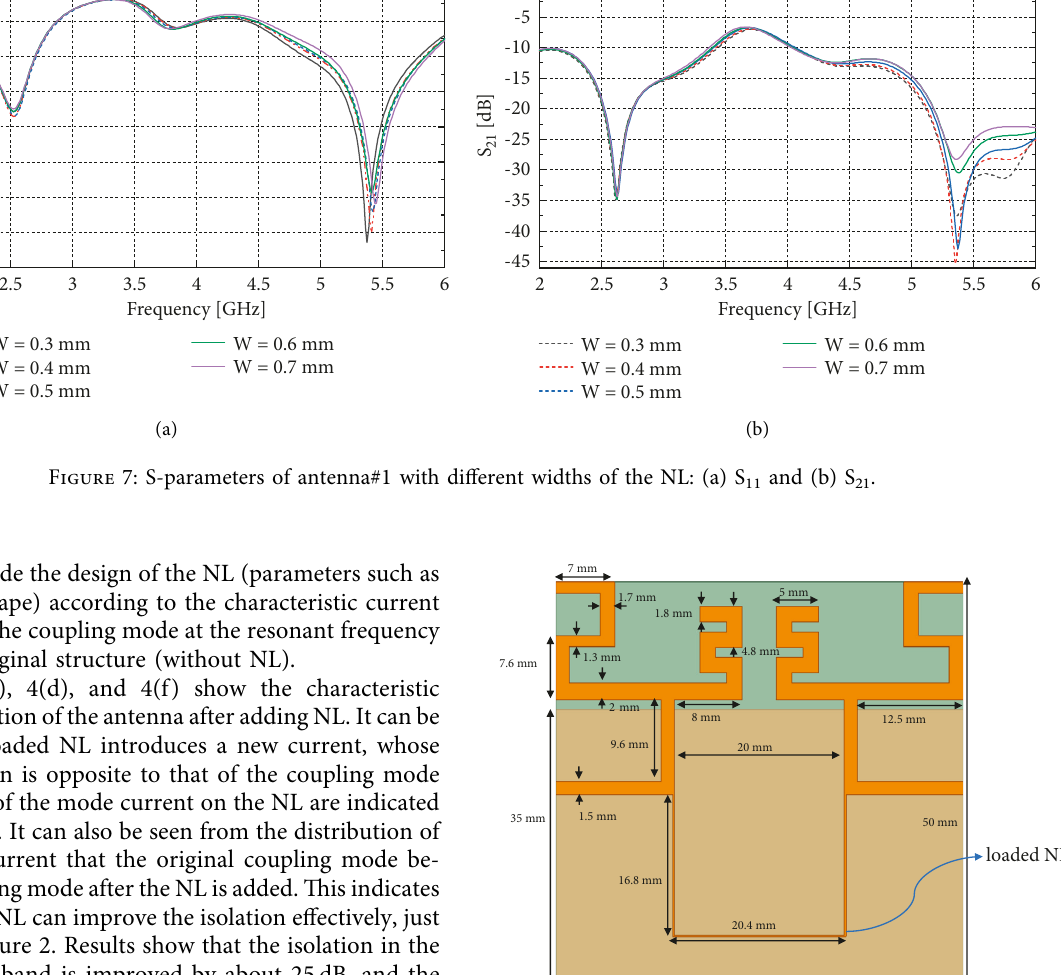
Figure 8: Overall structure of the MIMO